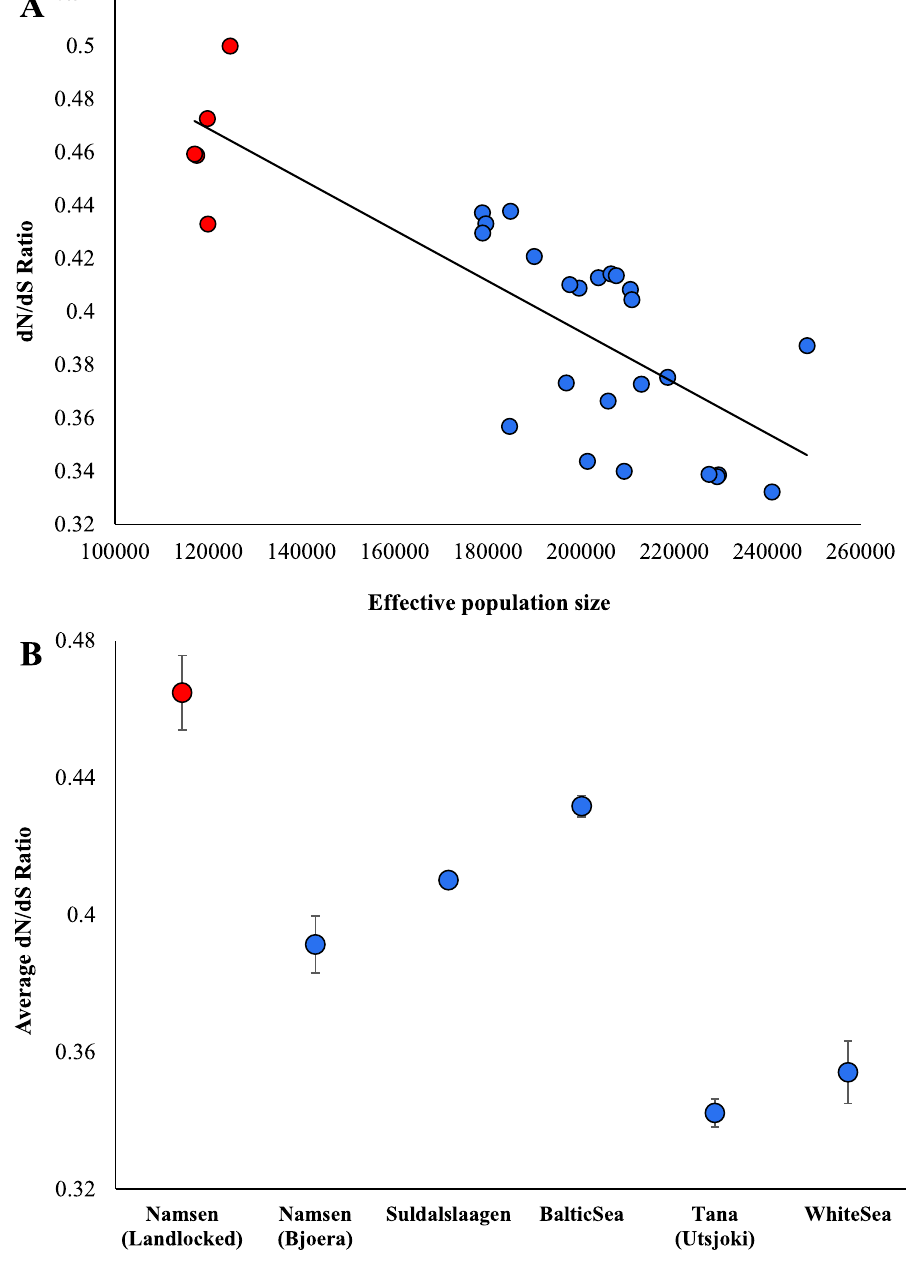
Figure 4. ( A ) The correlation between effective population size and the ratio of nonsynonymous and synonymous diversities (dN/dS). The relationship was highly significant ( r = 0.79, P < 0.000001). The best-fitting regression line is shown. ( B ) The average dN/dS ratio was estimated for landlocked and anadromous salmon populations. Error bars show the standard error of the mean. The ratio observed for landlocked salmons was significantly higher than those of anadromous ones (at least, P =